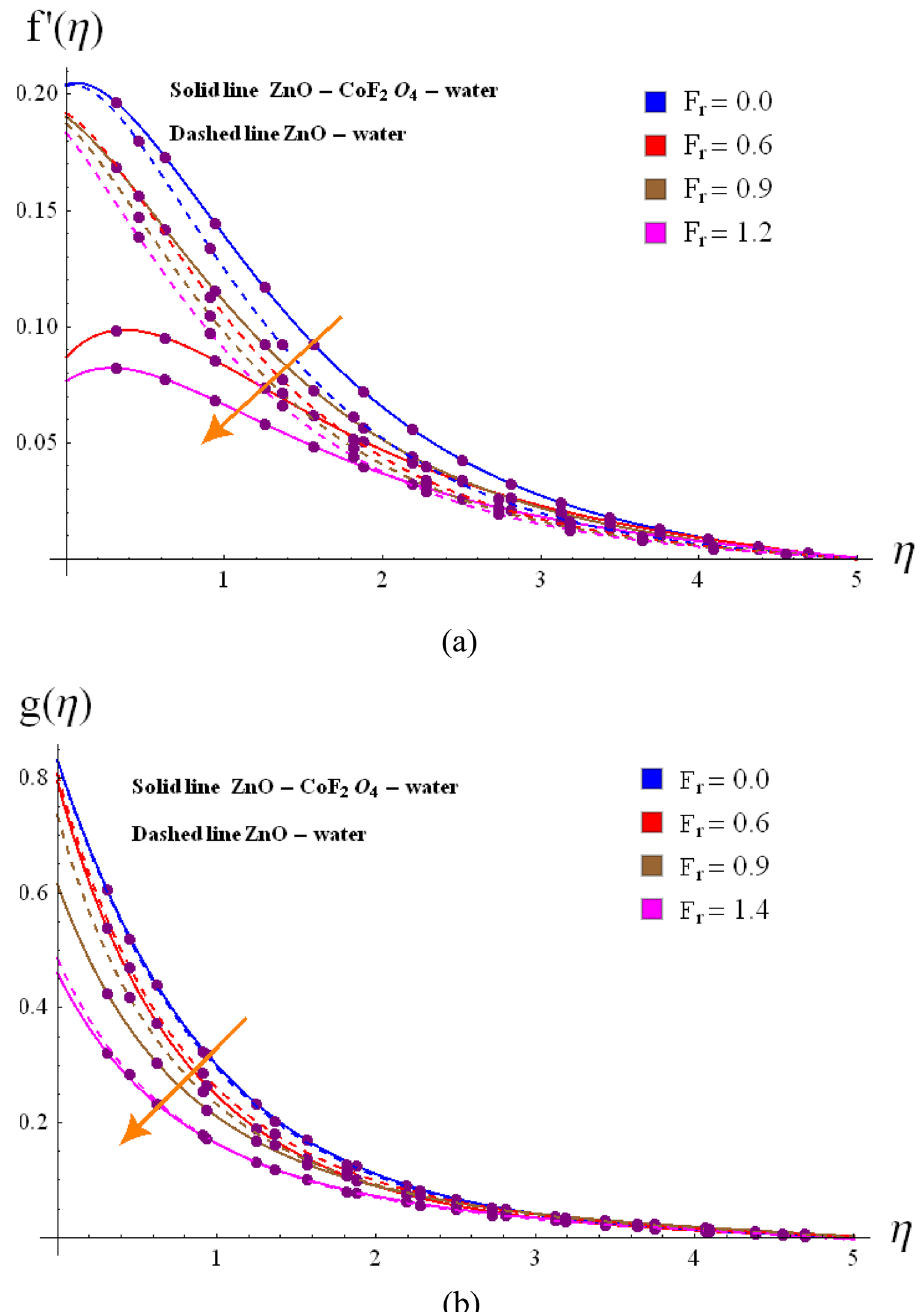
Figure 3. ( a ) Variation of f ′ (η) via F r . ( b ) Variation of g (η) via F r